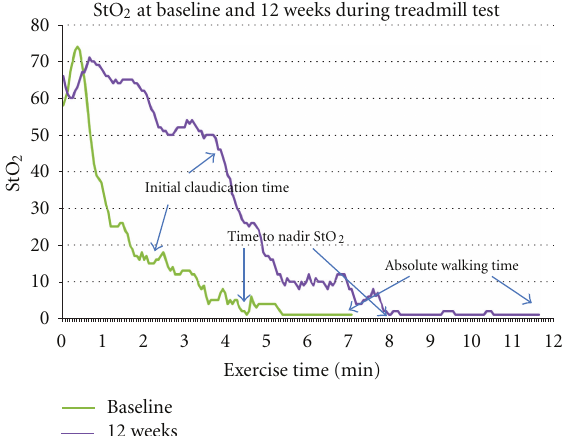
Figure 1: StO 2 data from sample patient at baseline and 12 weeks.